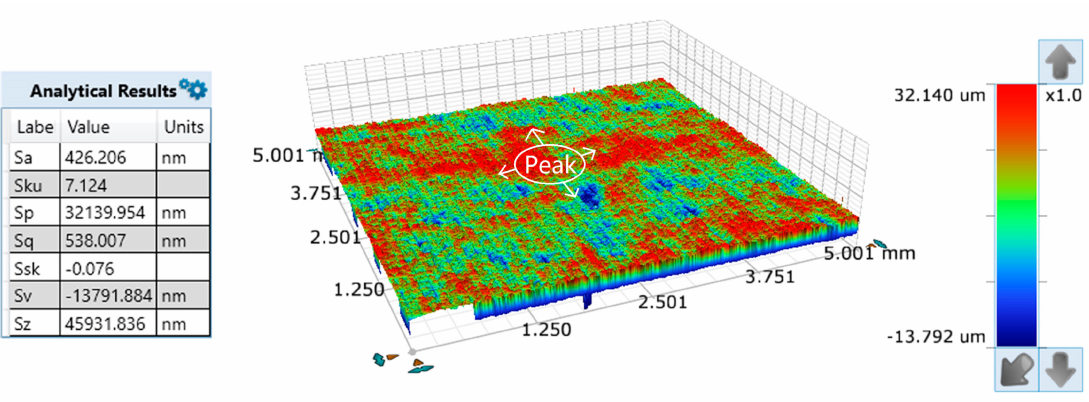
Figure 7. Topography of polished surface by CW laser and measured